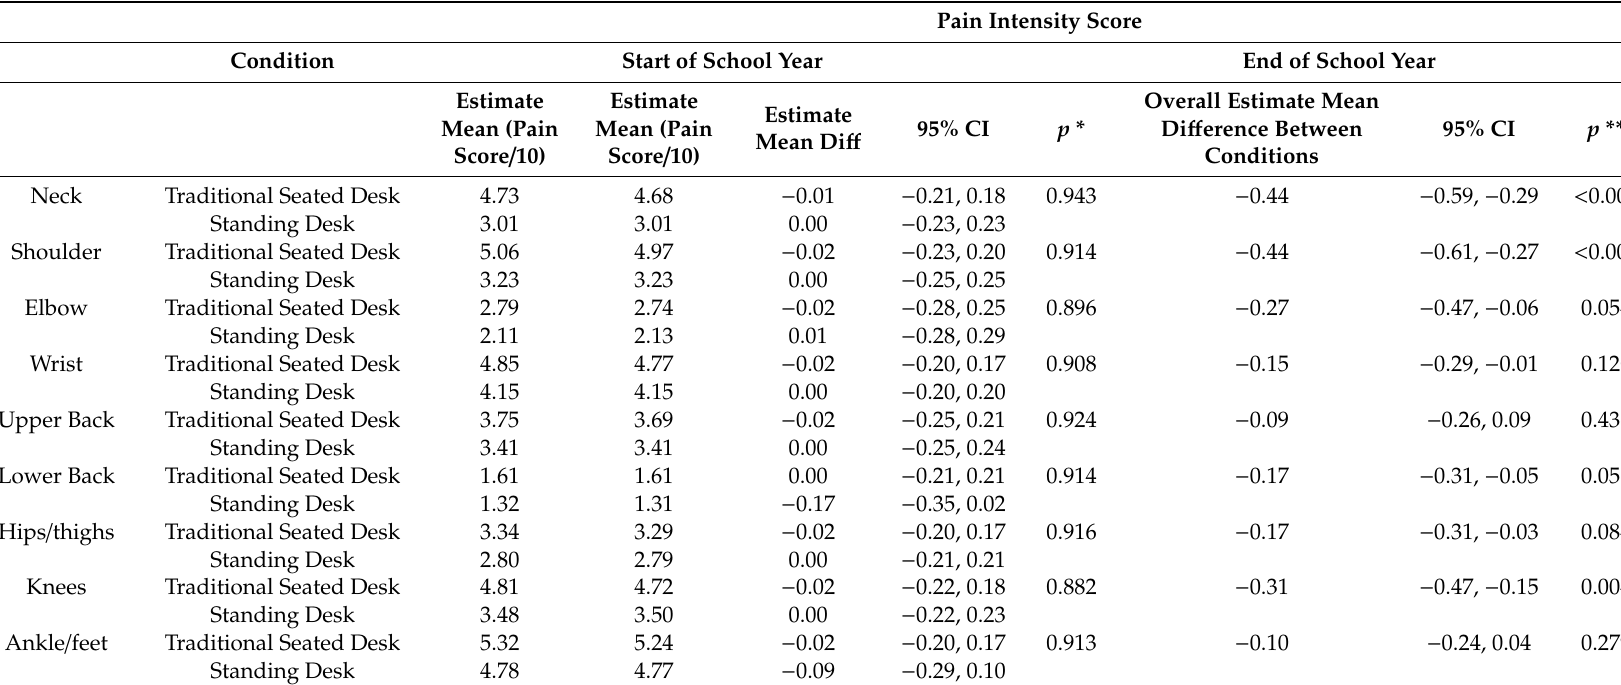
Table 3. Comparison of pain intensity in di ff erent body regions between standing desk and traditional seated desk conditions and over time (start of school year and end of school year). Pain Intensity Score Condition Start of School Year Estimate Estimate Overall Estimate Mean Estimate Mean (Pain Mean (Pain Di ff erence Score / 10) Score / 10)